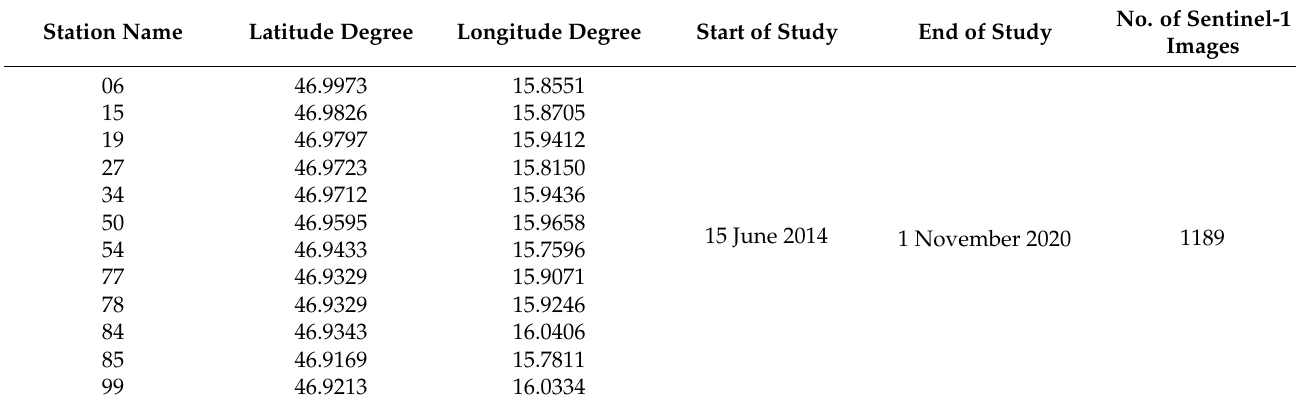
Table 2. Coordinates for each station of the WegenerNet network together with the number of Sentinel-1 images available for the location of each